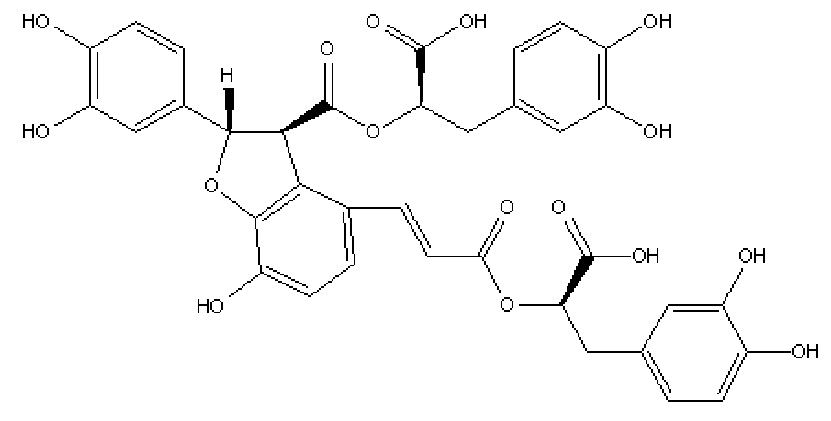
Figure 1. The molecular structure of Sal B.